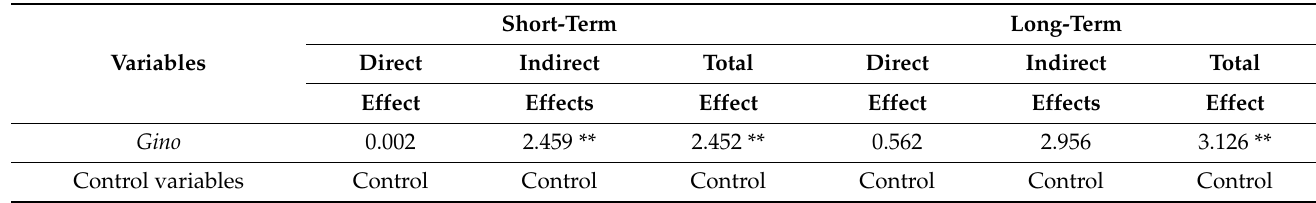
Table 7. Decomposition of spatial effects under nested